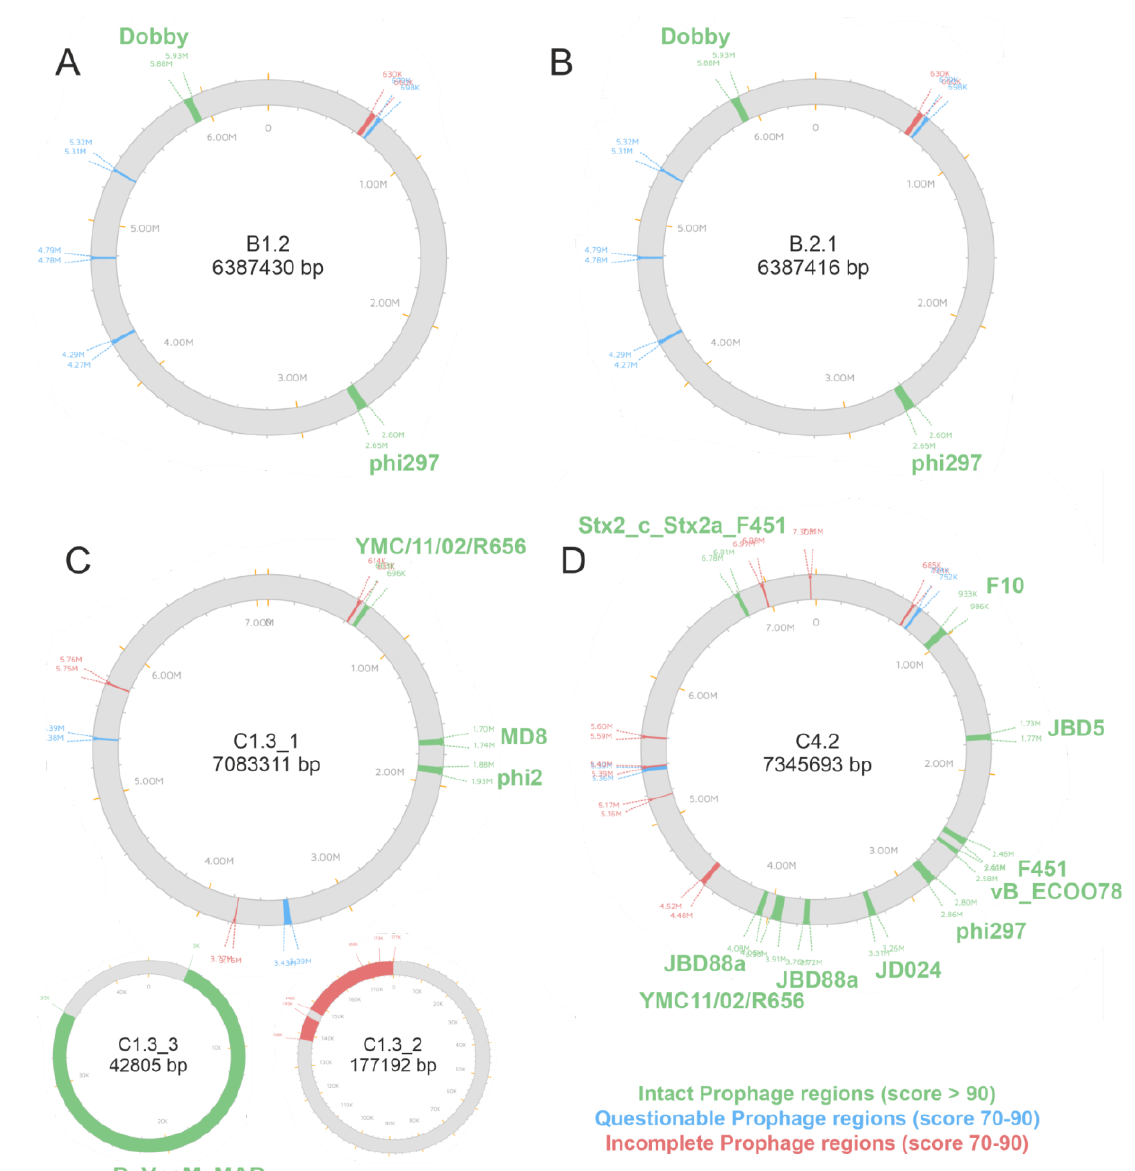
Figure 6. Identification of prophage regions. Prophages were identified using the PHASTER web tool and are indicated at their integration sites. Intact prophage regions are displayed in green, questionable prophage regions in blue and incomplete prophage regions in red. Only intact prophage regions are